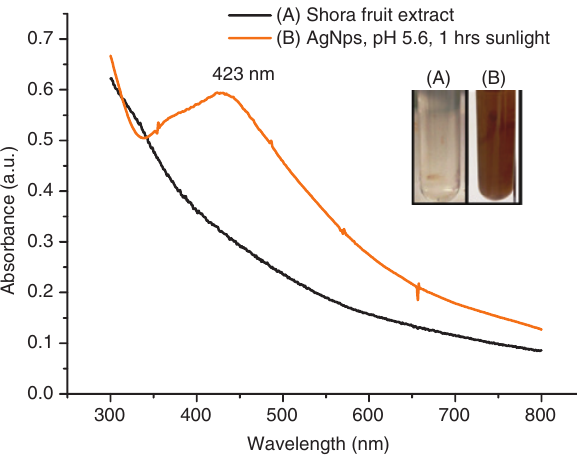
Figure 4: Visual and UV-vis absorption spectra of the synthesized silver nanoparticles (AgNps) using sunlight and Shora fruit